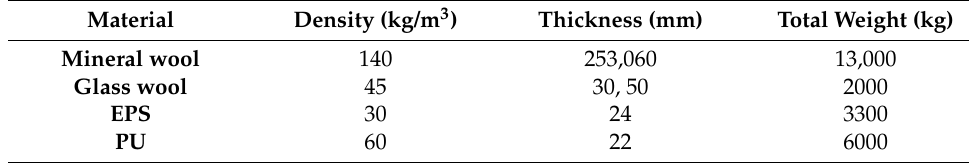
Figure 3. Conceptual example of the case ship’s fire protection plan. Table 3. Material